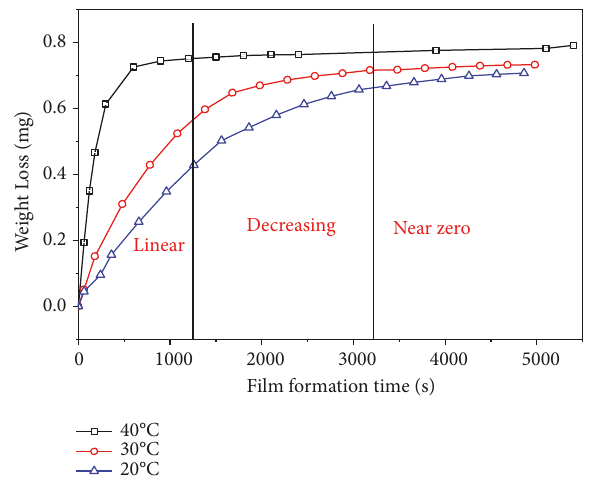
Figure 3: The solvent evaporation process at different film formation temperatures.